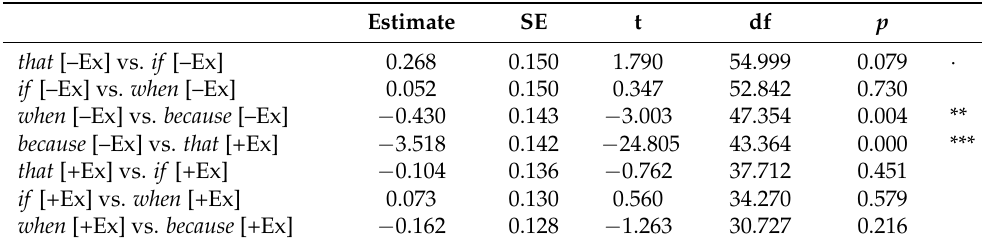
Table 5. Summary of the mixed effects model for filler type 2 (coordinate structure).